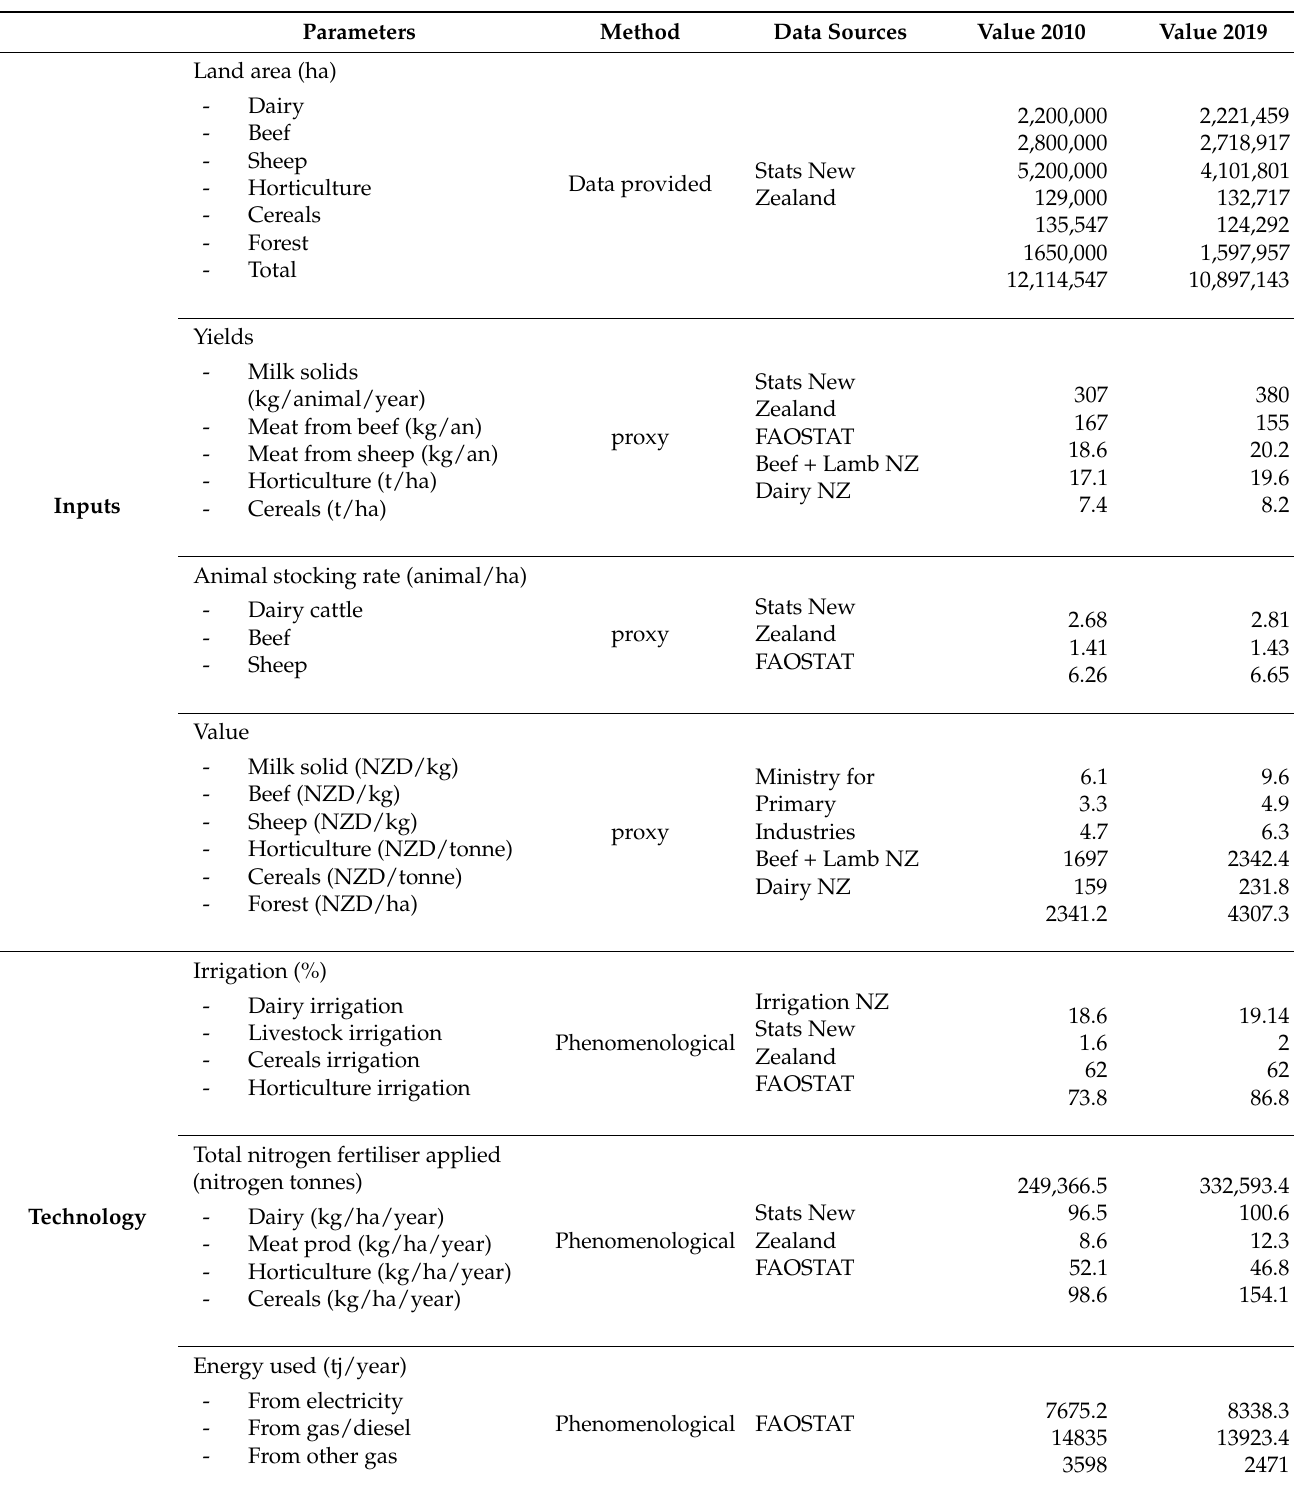
Table 2. Model development (2019) and validation (2010) data: parameters, determination methods, data sources, and